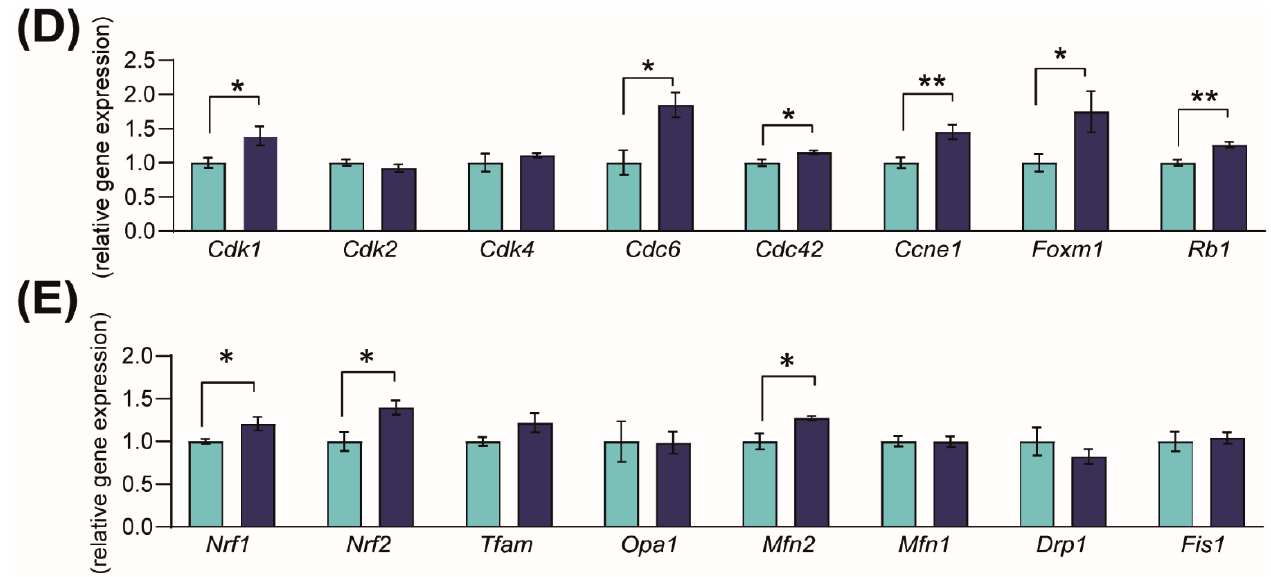
Figure 4. Abundance of proteins in growth ‐ signalling pathways and expression of cell ‐ cycle reg ‐ ulatory genes in the kidney in response to pregnancy in mice. ( A – C ) Immunoblots and quantifi ‐ cation of PI3K ‐ AKT, PPAR ‐ AMPK and MAPK ‐ JNK signalling proteins in the kidneys of non ‐ preg ‐ nant and pregnant female mice (n = 5/group) ( D , E ). Expression of genes related to cell ‐ cycle pro ‐ gression and mitochondrial ‐ related genes in kidneys of non ‐ pregnant and pregnant female mice (n = 4–5/group). Data are presented as mean ± SEM and were analysed by unpaired Student’s t ‐ test. Asterisks represent significant differences between non ‐ pregnant and pregnant mice (* p < 0.05; ** p < 0.01; *** p < 0.001; **** p < 0.0001).